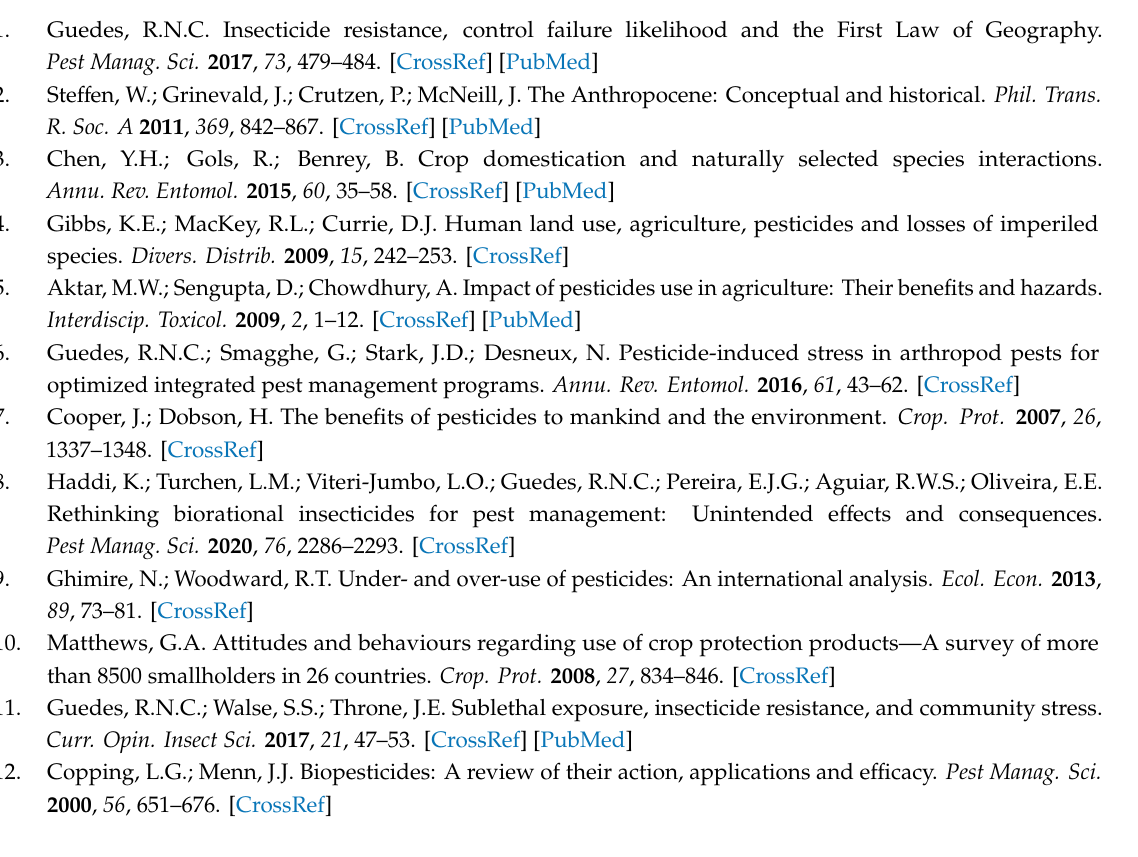
Table S1: Operational questions to systematize the survey of publications on the use of botanical insecticides, Table S2: Listed of retrieved articles and their respective summaries that were used for survey and meta-analyses. Author Contributions: Conceptualization and methodology, L.M.T. and R.N.C.G.; software, L.M.T.;